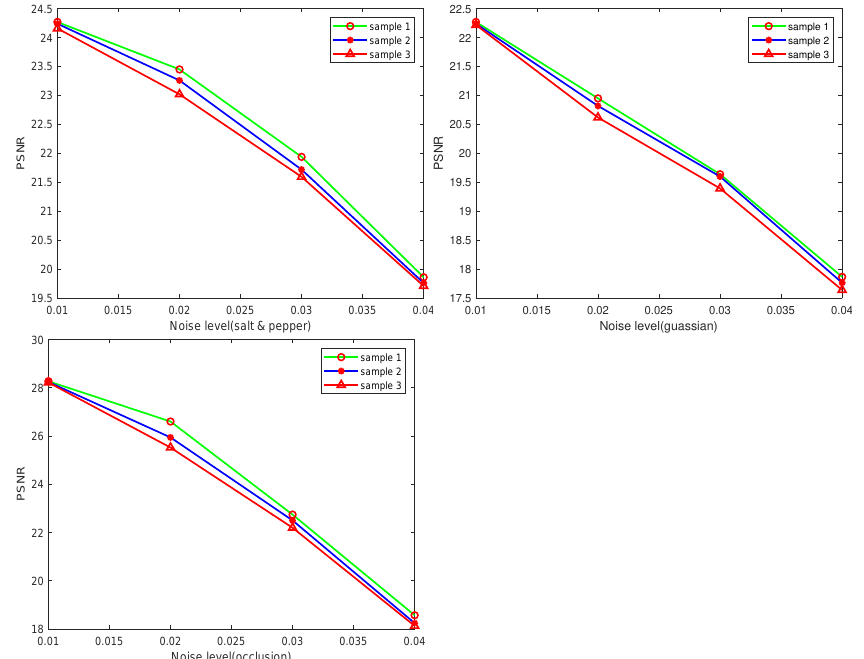
Figure 17. PSNR results of affected decrypted